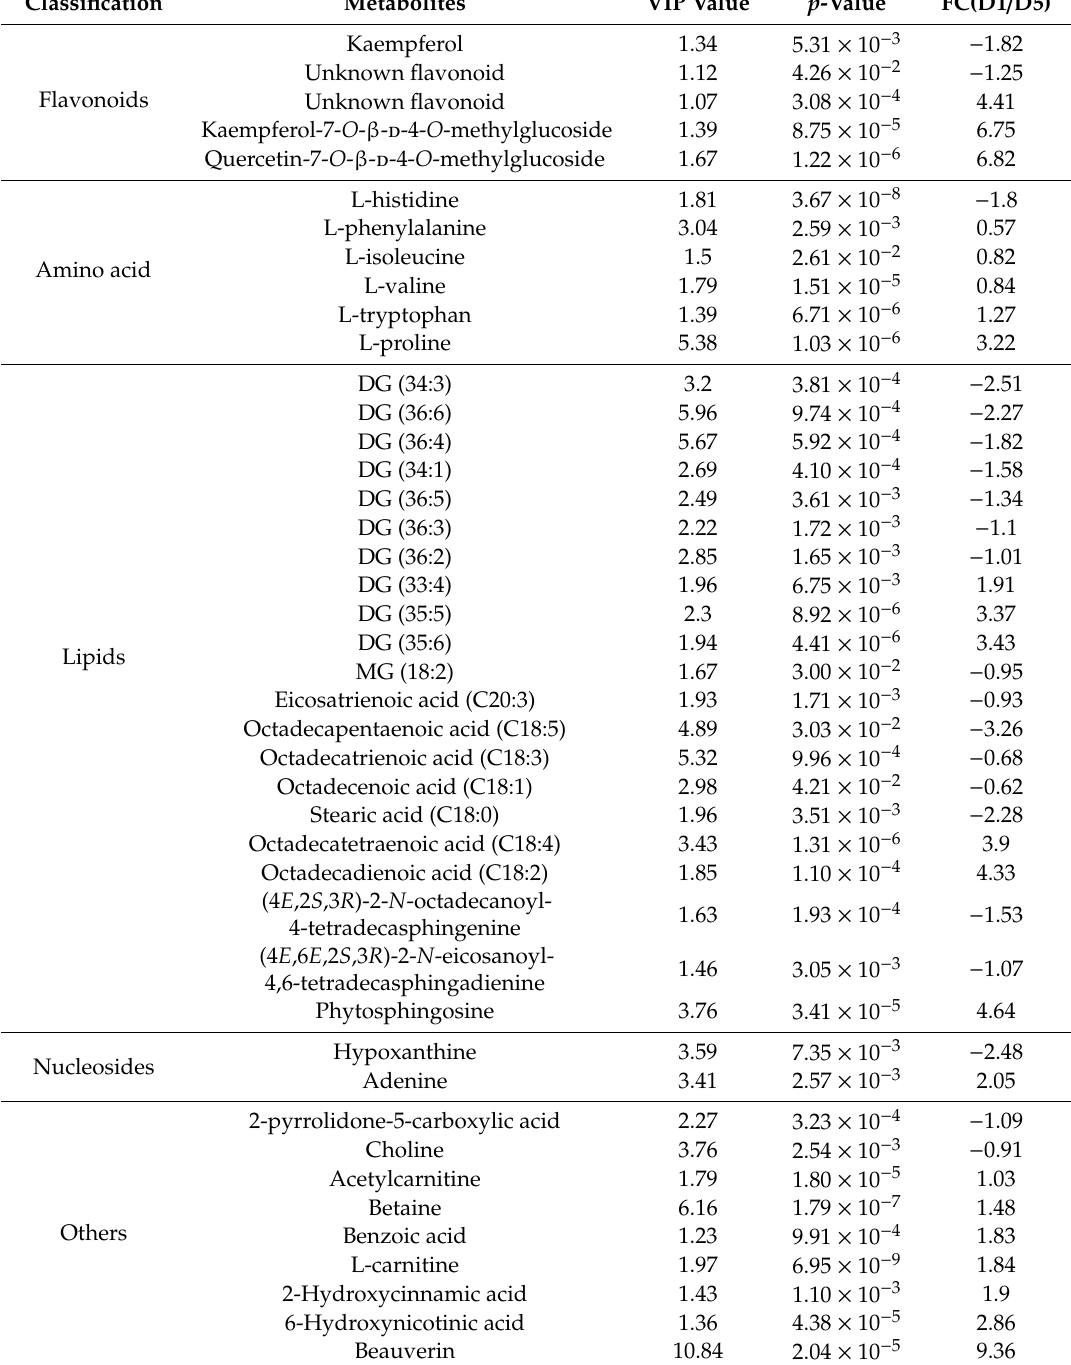
Table 3. Di ff erential metabolites between groups (D1 vs.